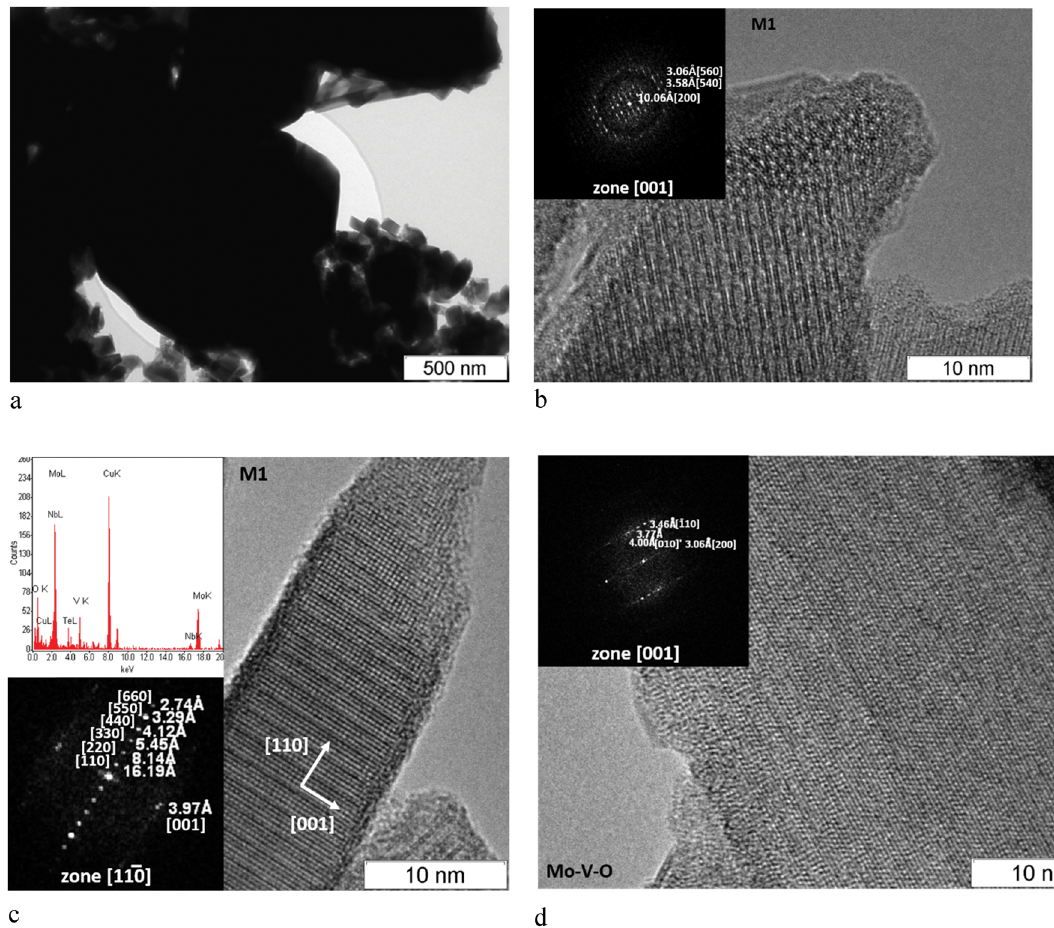
Figure 5: TEM image morphology ( a ) , HRTEM and FFT images with labeled observed interplanar distances and corresponding indexes for phases M1 ( b and c ) and Mo – V – O ( d ) of MoVTeNbO catalyst after